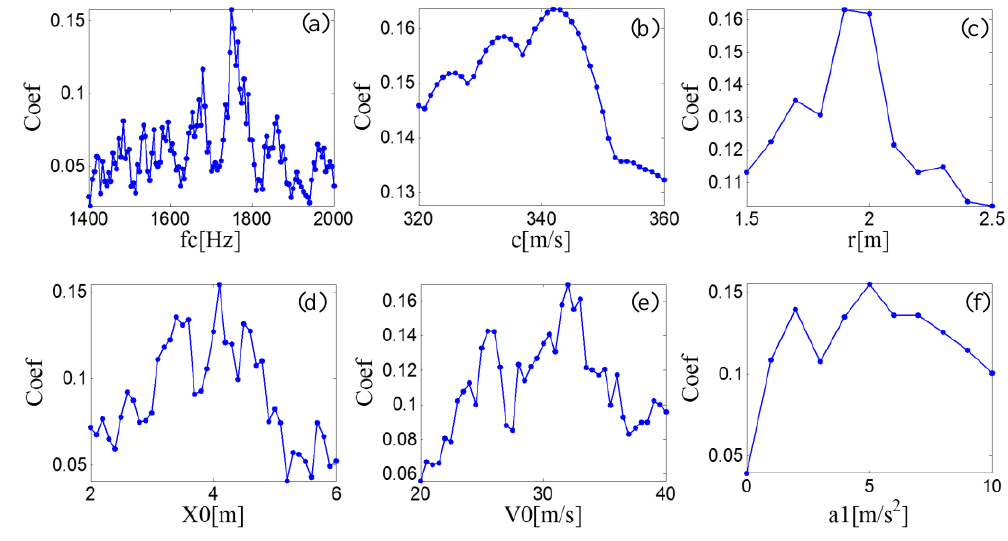
Figure 22. Maximal correlation coefficients for the different elements from a specified PMDW model parameter subset for the Doppler-shifted signal with the inner-race defect.